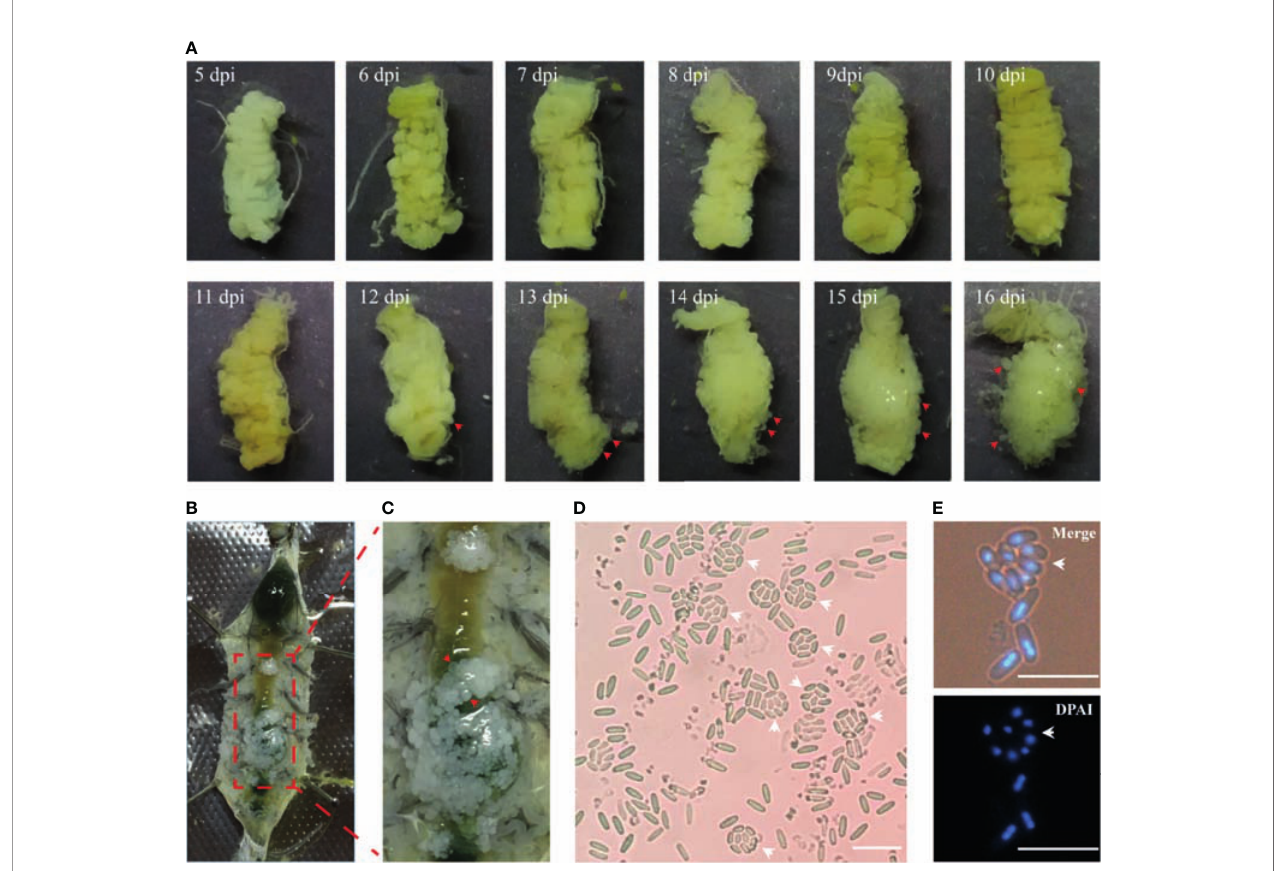
FIGURE 1 | The development of xenoma on the midgut of silkworm infected by V. necatrix BM. (A) The silkworm midgut from 5 to 16 dpi. The xenomas (arrowhead) could be observed after 12 dpi and were obvious after 13 dpi. The midgut was surround by massive xenomas after 16 dpi; (B) The infected silkworm larva was dissected in the 5 th instar; (C) Massive whitish xenomas (arrowhead) were shown on the outer surface of the infected midgut; (D, E) The V. necatrix BM in a xenoma produced a large number of meiospores (octospores) contained within a sporophorous vesicle (arrowhead). The bar indicates 10